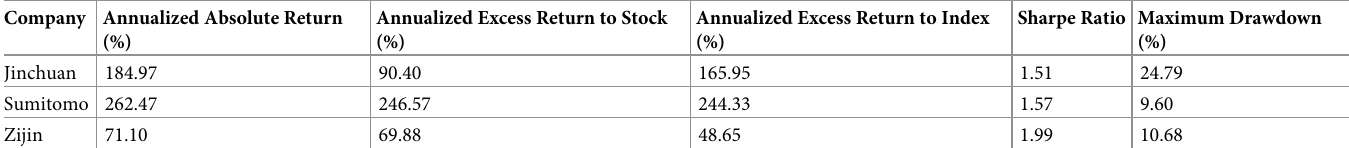
Table 8. Evaluations on trading strategies. The returns have been annualized using 250 days as the number of trading days in a year. Company Annualized Absolute Return